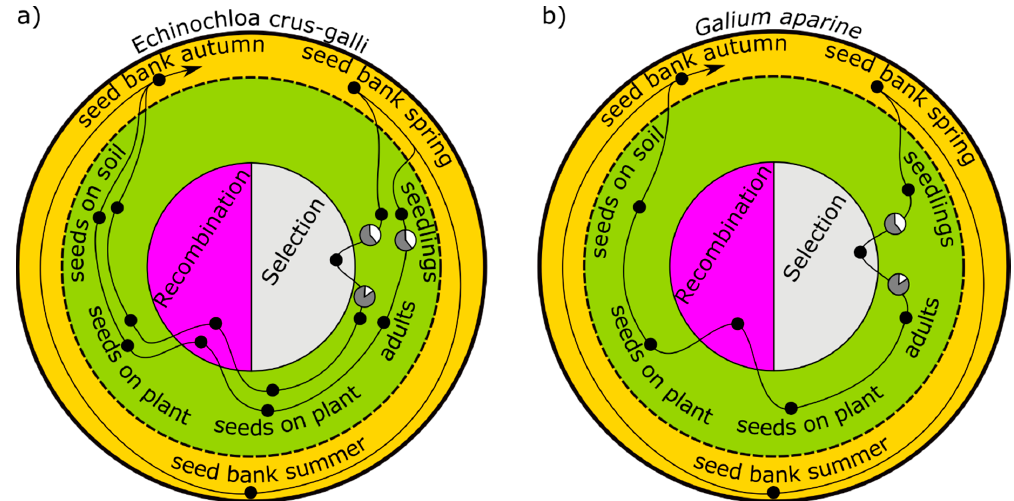
Figure 2. Structure of population dynamic models for: ( a ) Echinochloa crus-galli , with two cohorts; and ( b ) Galium aparine , with one cohort. Legend: see Figure 1.